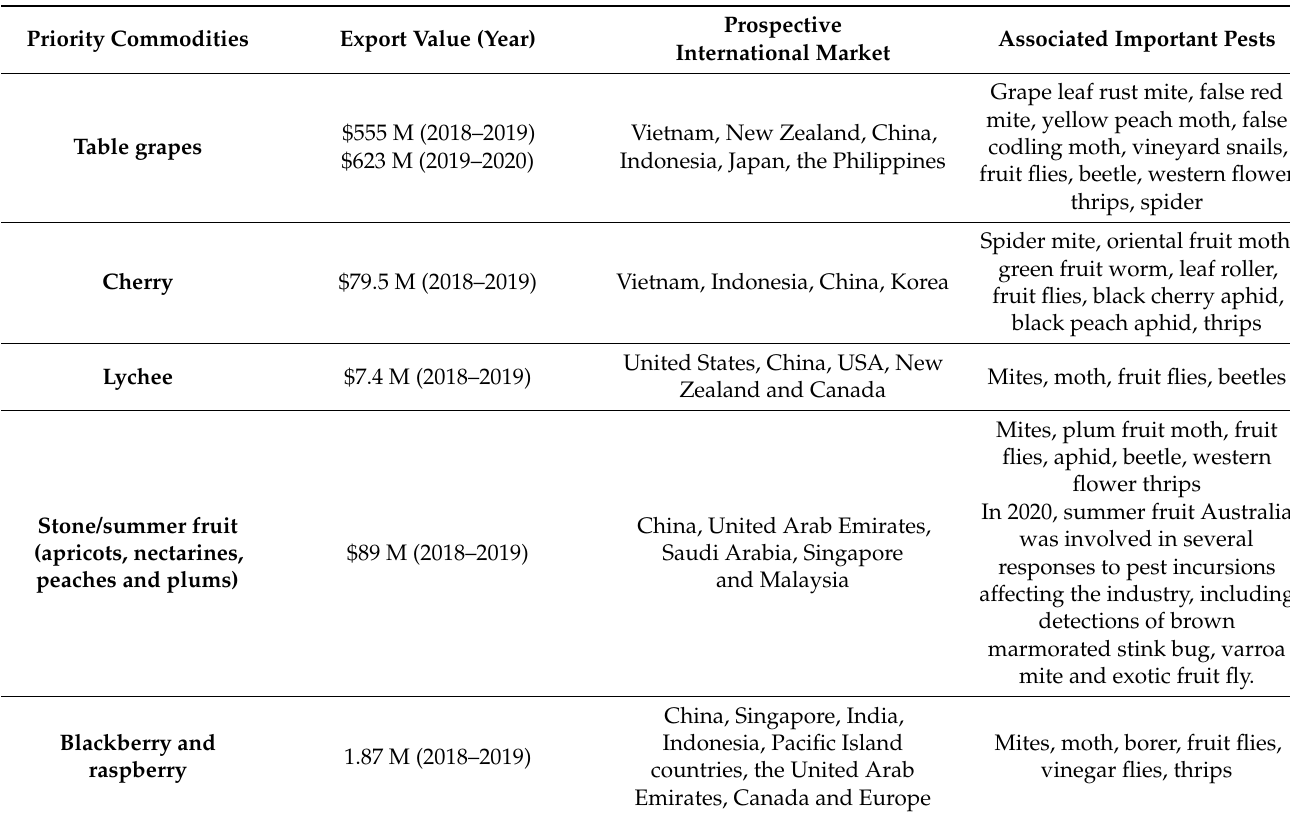
Table 1. Priority commodities that have high demand in international market and associated pests of quarantine concern for Australian horticultural